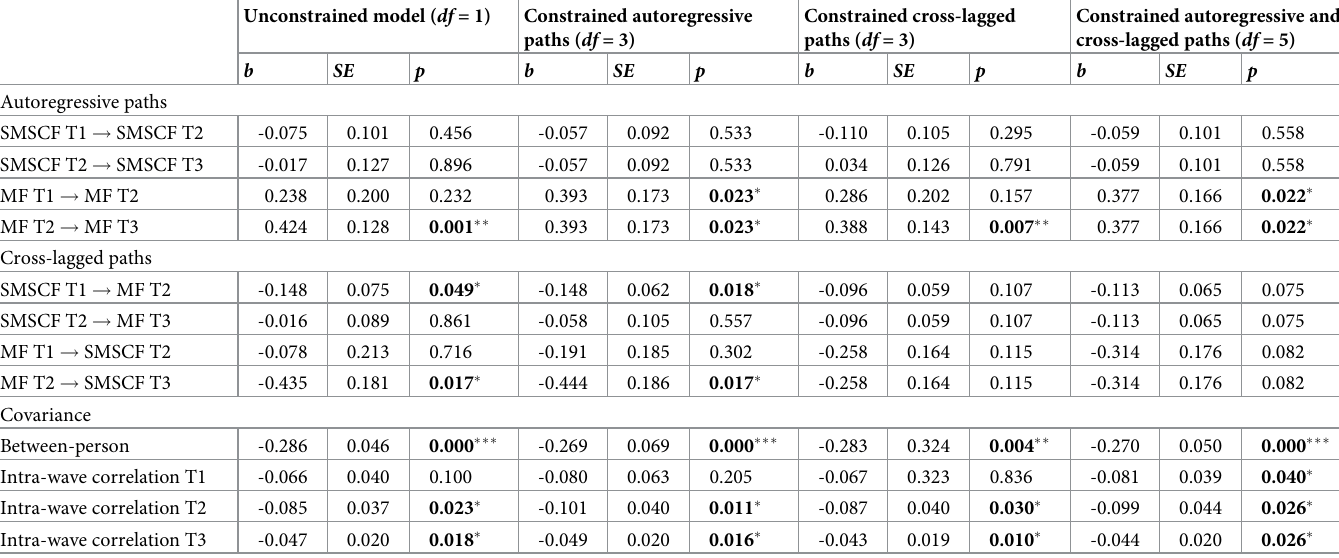
Table 6. Reciprocal relationships between social media self-control failure and mindfulness.